Question: Summarize what this figure shows in one sentence.
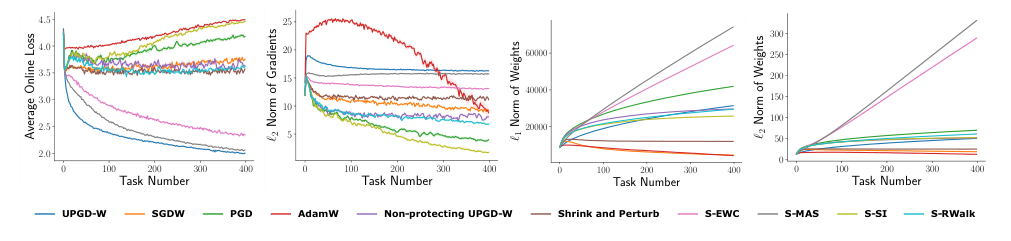
Answer: Diagnostic Statistics of methods on Label-permuted mini-ImageNet. The average plas- ticity, percentage of zero activations, ℓ0, ℓ1 and ℓ2-norm of gradients, the average online loss, the ℓ1-norm and ℓ2-norm of the weights are shown. The shaded area represents the standard error.